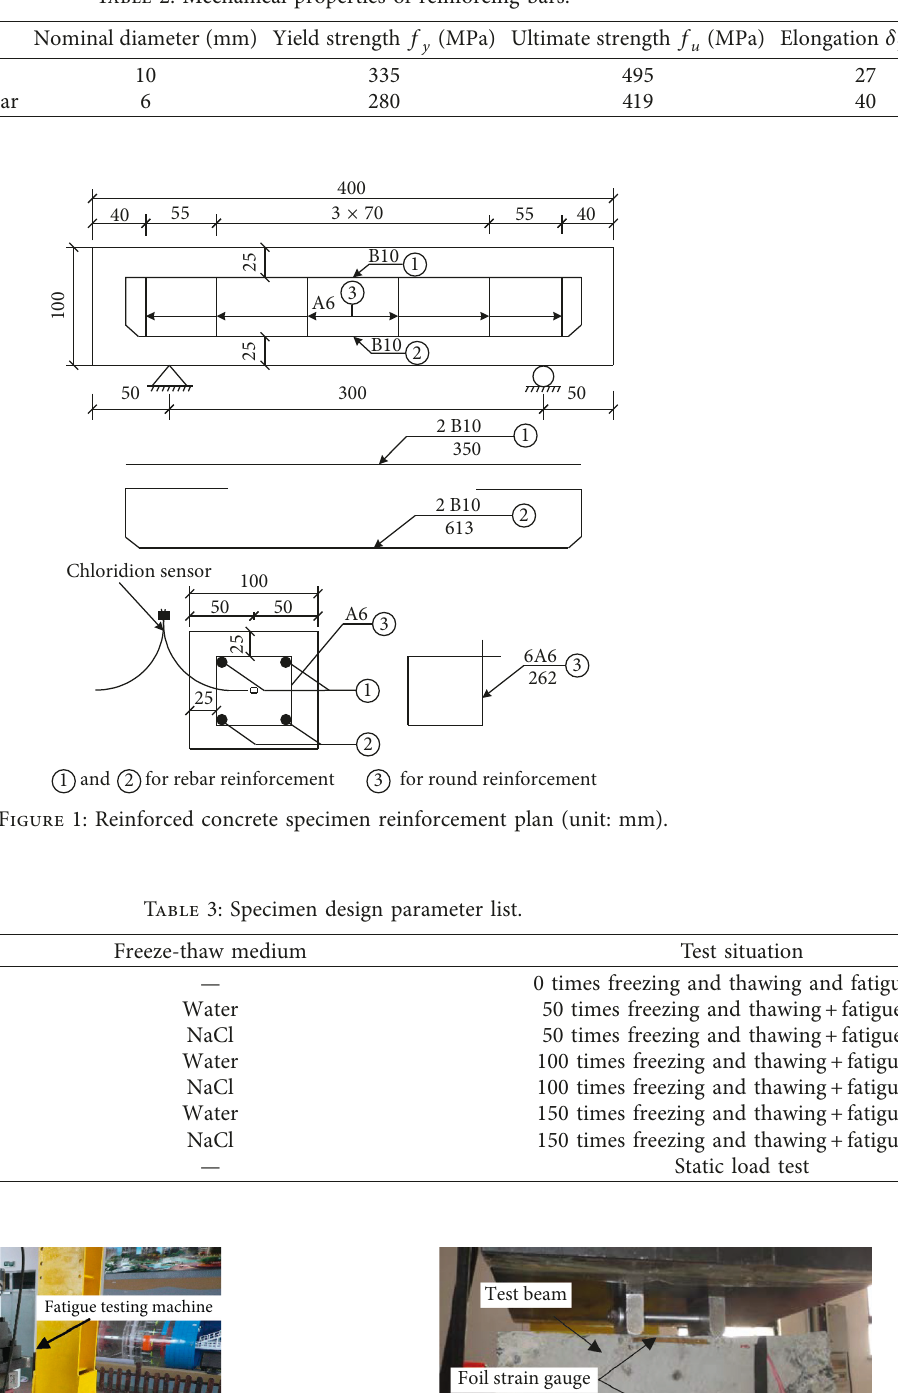
Table 2: Mechanical properties of reinforcing bars.